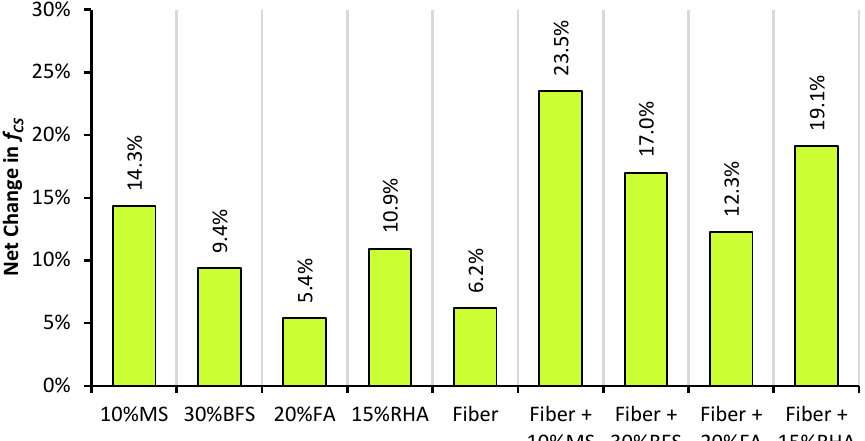
Figure 7. The net change in f CS of PRAC and GFRRAC due to the addition of mineral admixtures (MS, BFS, FA, and RHA).